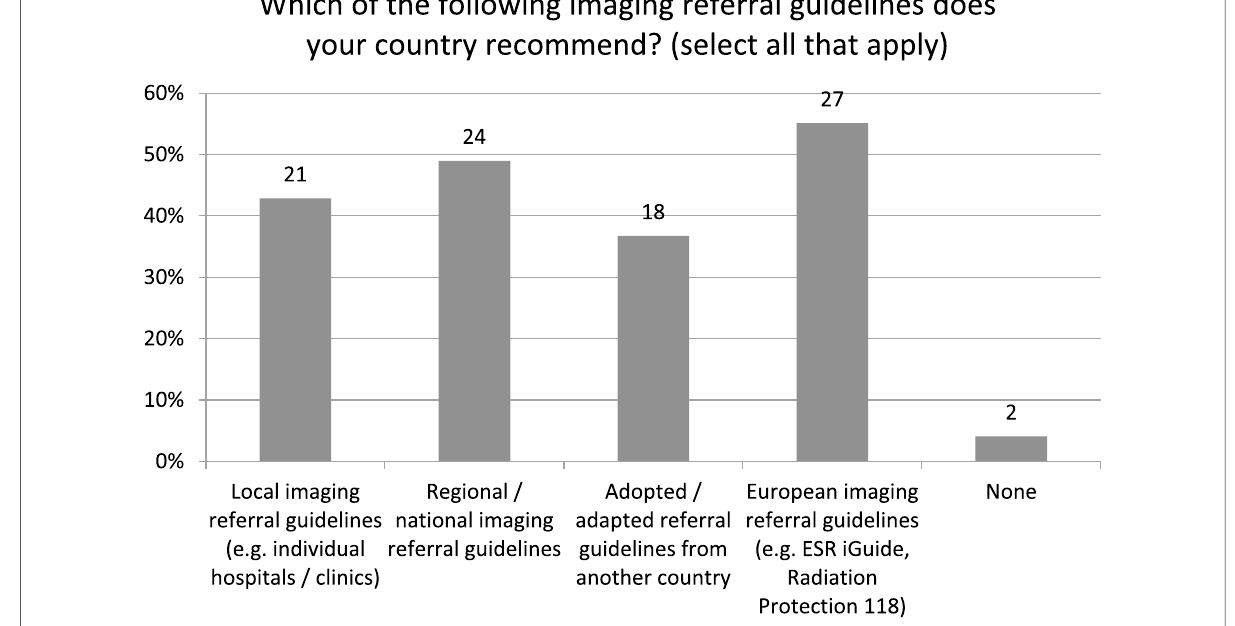
Fig. 3 Which of the following imaging referral guidelines does your country